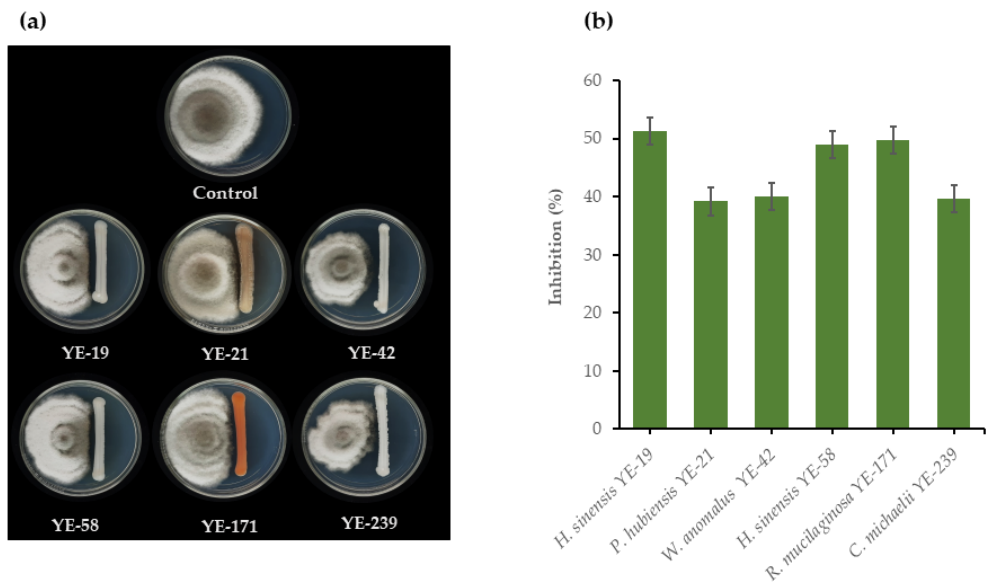
Figure 2. ( a ) Growth on PDA at 25 ◦ C for seven days of Helminthosporium oryzae DOAC 2293 alone, and dual cultured with Hannaella sinensis YE-19, Pseudozyma hubiensis YE-21, Wickerhamomyces anomalus YE-42, H. sinensis YE-58, Rhodotorula mucilaginosa YE-171 and Candida michaelii YE-239; and ( b ) Inhibition of H. oryzae DOAC 2293 growth by six antagonistic yeast strains determined by dual cultivation on PDA at 25 ◦ C for seven days.